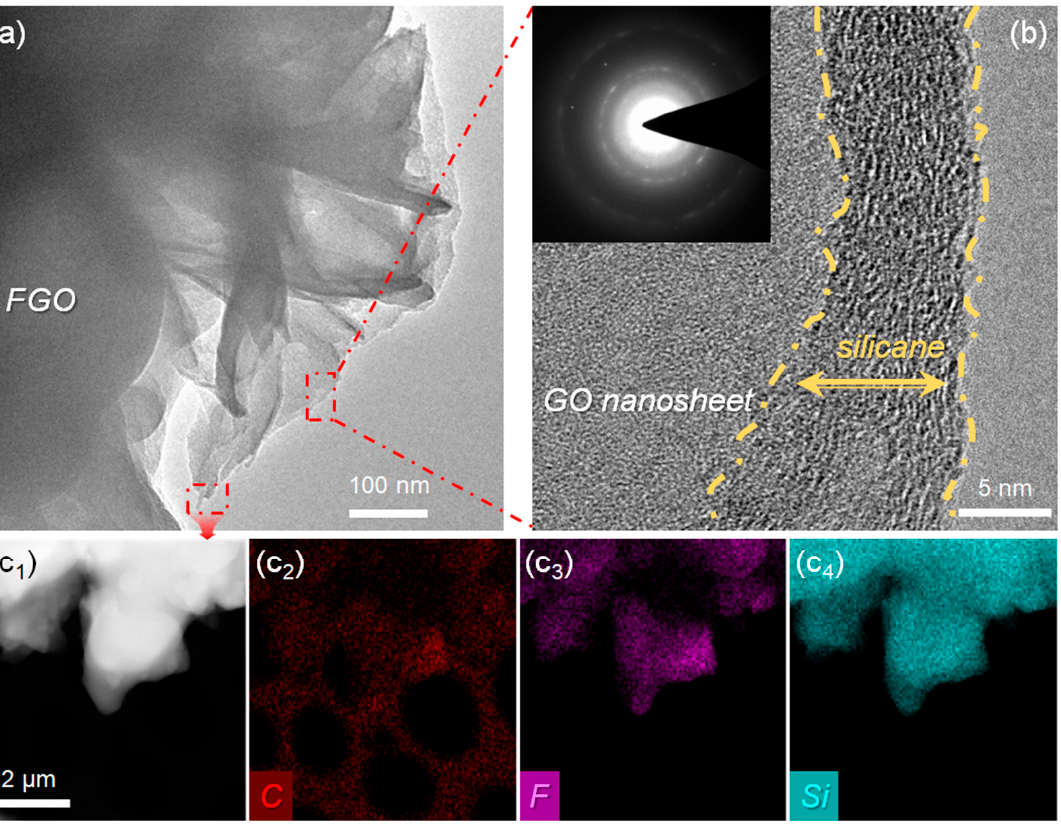
Figure 3. ( a ) TEM image, ( b ) high-resolution TEM image (the inset is the selected area electron dif- fraction), and ( c1 – c4 ) EDS mapping of